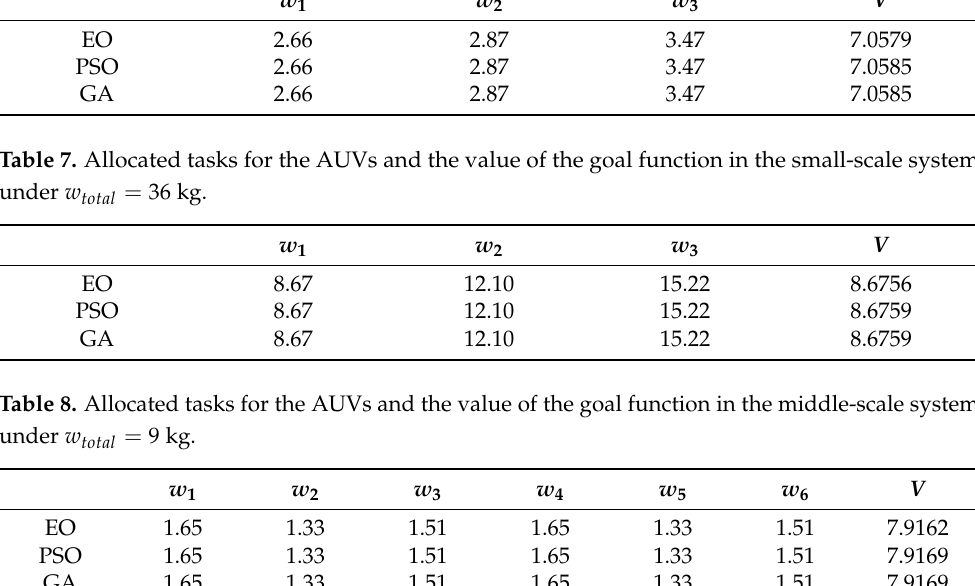
Table 6. Allocated tasks for the AUVs and the value of the goal function in the small-scale system under w total = 9 kg. w 1